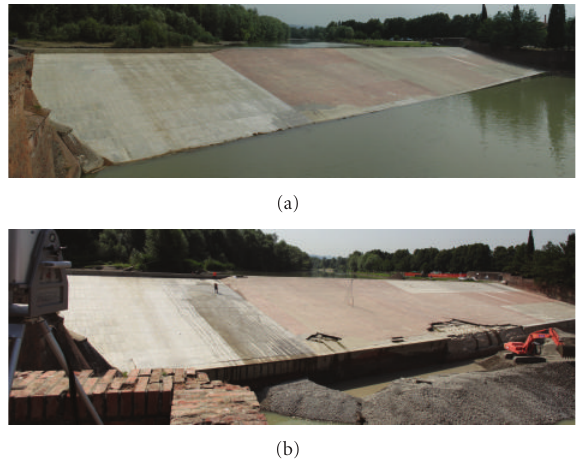
Figure 2: Images of the sluice, taken in 2005 (a) and 2009 (b); the second shows the damages su ff ered after the winter season 2008- 2009. depressed portion of the barrier, located at a distance of 71 meters from the right edge. The height di ff erence between the upper and lower margins is 8.03